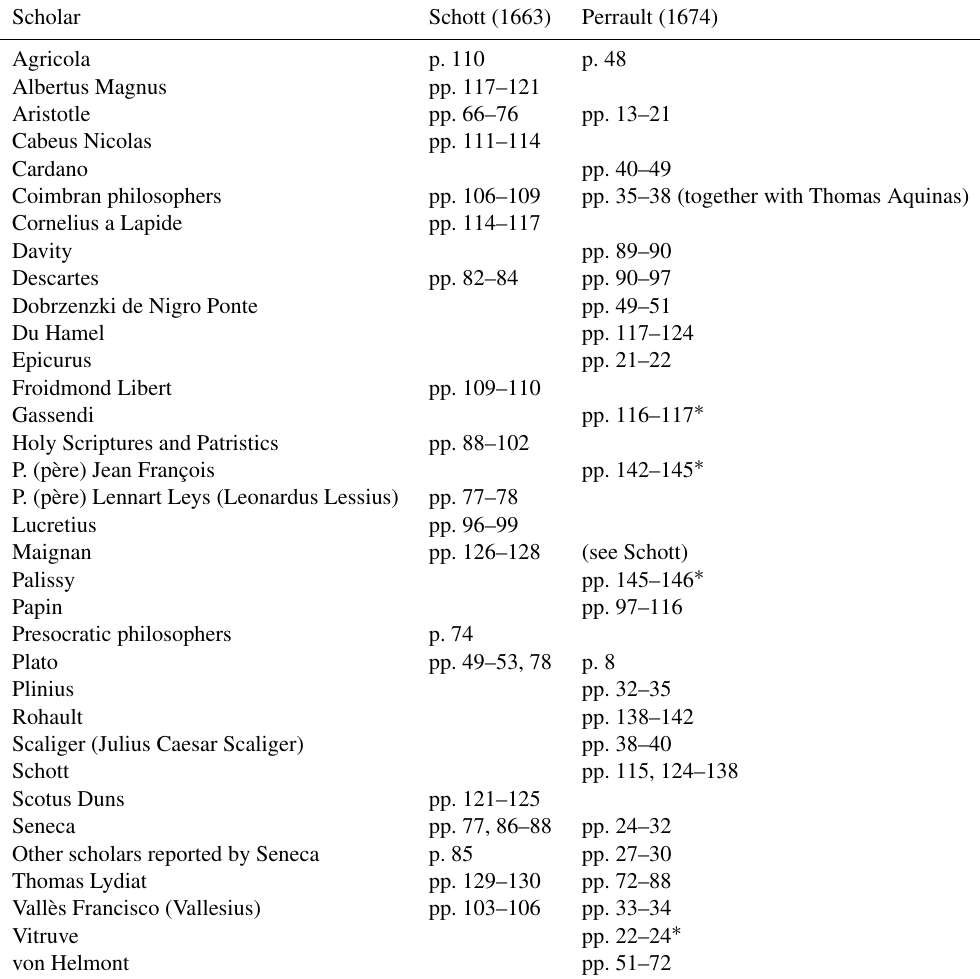
Table 1. List of previous scholars referred to by Schott (1663) and by Perrault (1674).